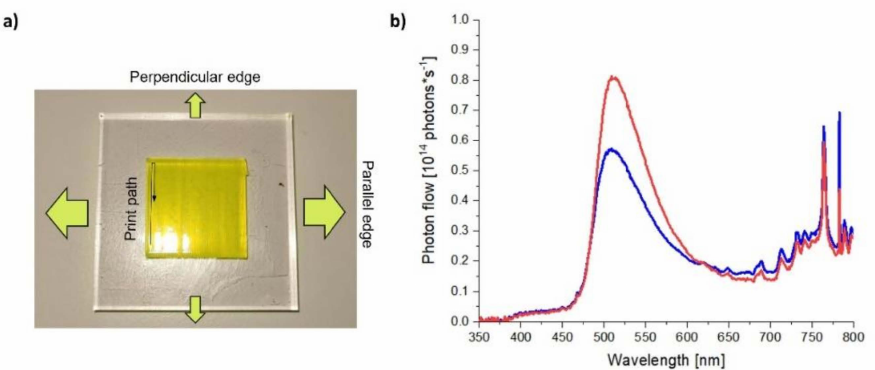
Figure 3. ( a ) Definition of perpendicular and parallel edge emissions. The direction of the original printing deposition is indicated, as well as the definitions of “perpendicular” and “parallel” edges. The green arrows represent the relative edge emissions from the two edges. ( b ) Representative comparison of edge emission spectra from the parallel (red line) and perpendicular (blue line) edges of a 0.05 wt% sample of K160 with S = 0.26. The spectral features >650 nm are measurement